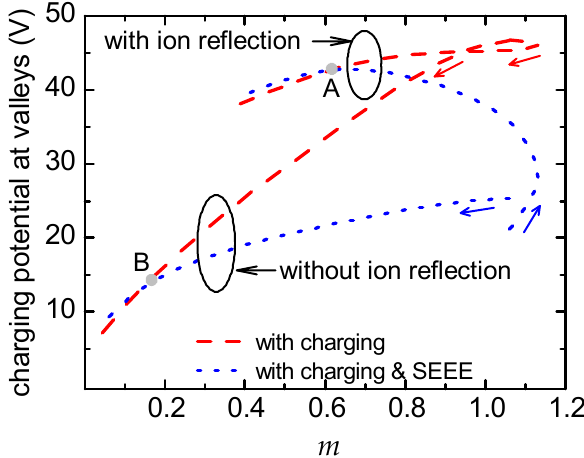
Figure 8. The charging potential (average value of potential at the four valleys of the profile) vs. parameter m (Equation (5)). The arrows on the curves denote the time path during etching. Values above 500 s of etching for the curves corresponding to cases without ion reflection have been removed as the profiles are almost flat (cf. Figure 7). The small difference (~3 V) observed in the initial potential between the two cases of SEEE is an expected difference between two runs of a stochastic process.